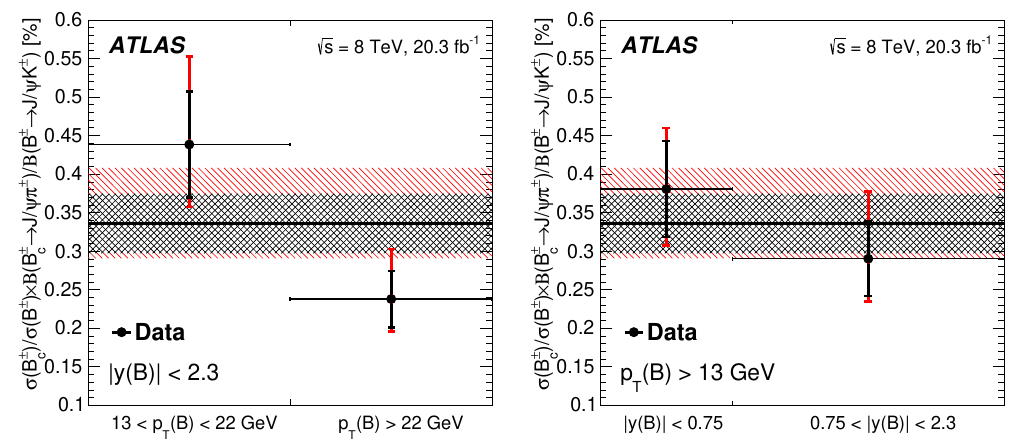
→ J /ψπ ± Figure 1: Measured production cross section times branching ratio for B ± c ( B ± ) (data points), and (right) relative to B ± → J /ψ K ± [ 3 ] : (left) for two bins in p T ( c ) ) | (data points). The inclusive bin is shown as horizontal two bins in rapidity | y ( B ± ( c ) band in both figures. The horizontal error bar on the data points indicates the bin width. The vertical inner error bars on the data points and the double hatched error band indicate the statistical uncertainty. The outer error bars and the single hatched error band indicate the size of the quadrature sum from all sources (statistical, sys- tematic,